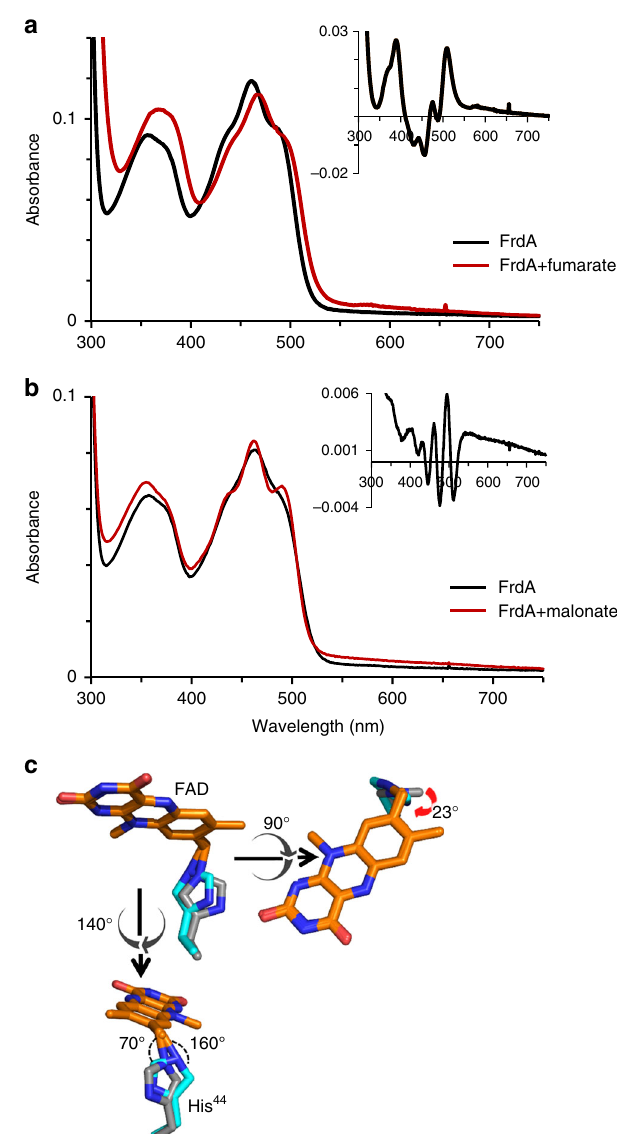
Fig. 5 Effect of SdhE on the requirements for covalent fl avinylation activity of FrdA. a , b Optical difference spectra measuring the binding of a 5 mM fumarate or b 2 mM malonate. Spectra were collected using the same protocol as for Fig. 4a with 6.6 µ M of the FrdA subunit. Insets show the difference spectra (FrdA – ligand complex minus free FrdA) for each corresponding complex. The difference spectra re fl ect a change in the FAD environment and were used to calculate the K d value. Data are representative traces from three or more analyses. c An overlay FrdA H44 from the FrdA-SdhE assembly intermediate (cyan) with that from mature FrdABCD (gray) highlights at 23° rotation of the FrdA H44 ligand. This is associated with a reduced distance to FAD C8 α and a change in angles of the imidazole N